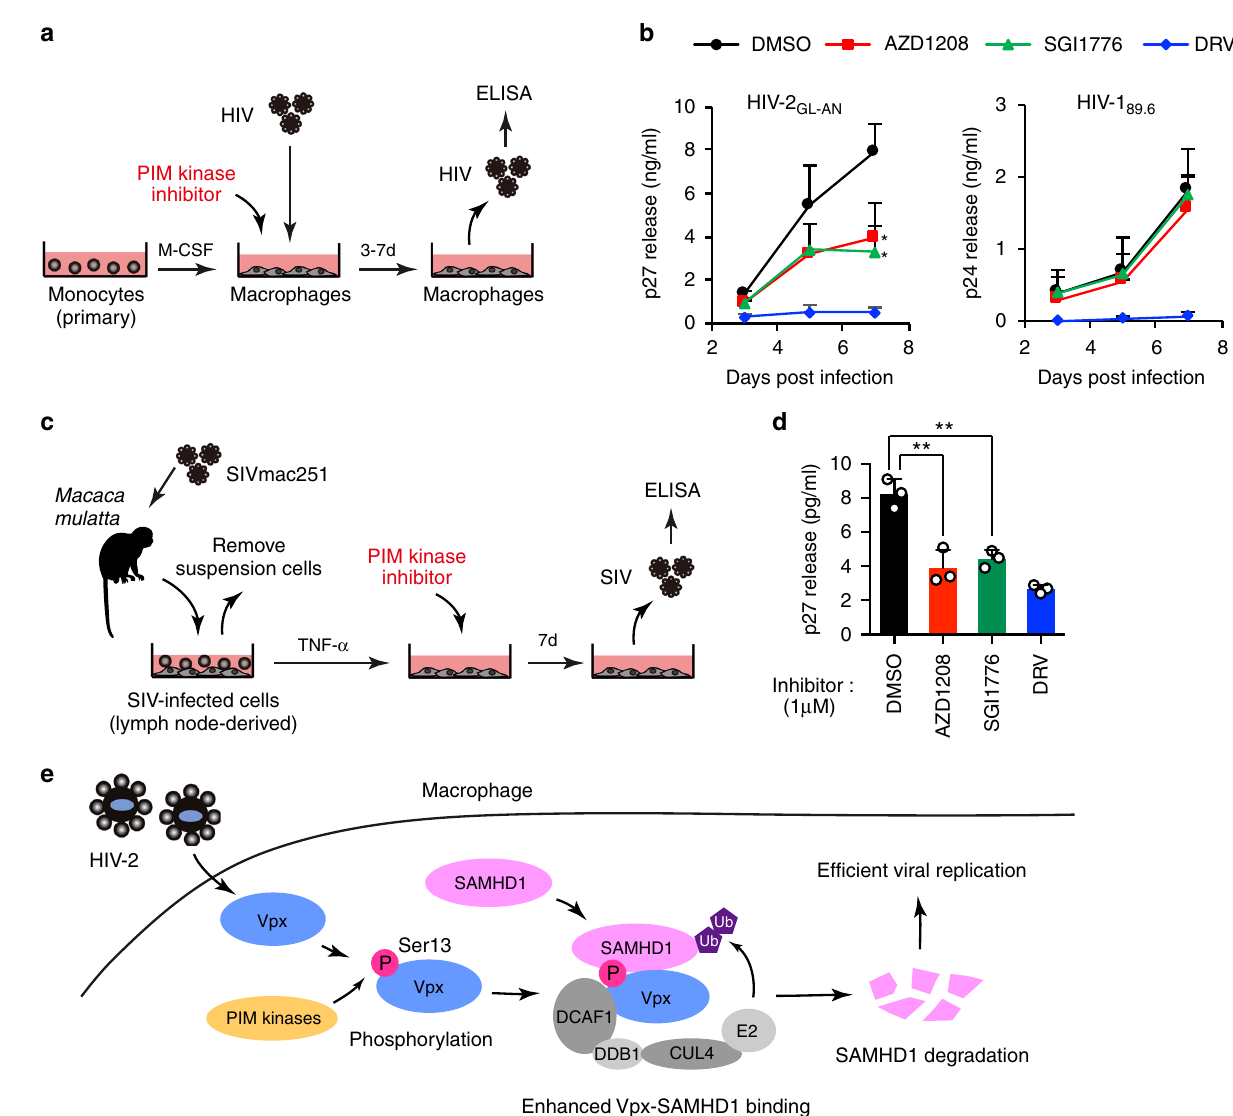
Fig. 7 PIM kinase inhibitors block lentiviral replication in primary macrophages. a , b HIV-2 replication kinetics in primary monocyte – derived macrophages. Schematic representation of the experimental design ( a ). Cells were infected with wild-type HIV-2 GL-AN or HIV-1 89.6 in the presence of AZD1208 or SGI1776 (1 µ M). A HIV protease inhibitor darunavir (DRV, 1 µ M) was used as a control. Replication kinetics were monitored by ELISA of extracellular